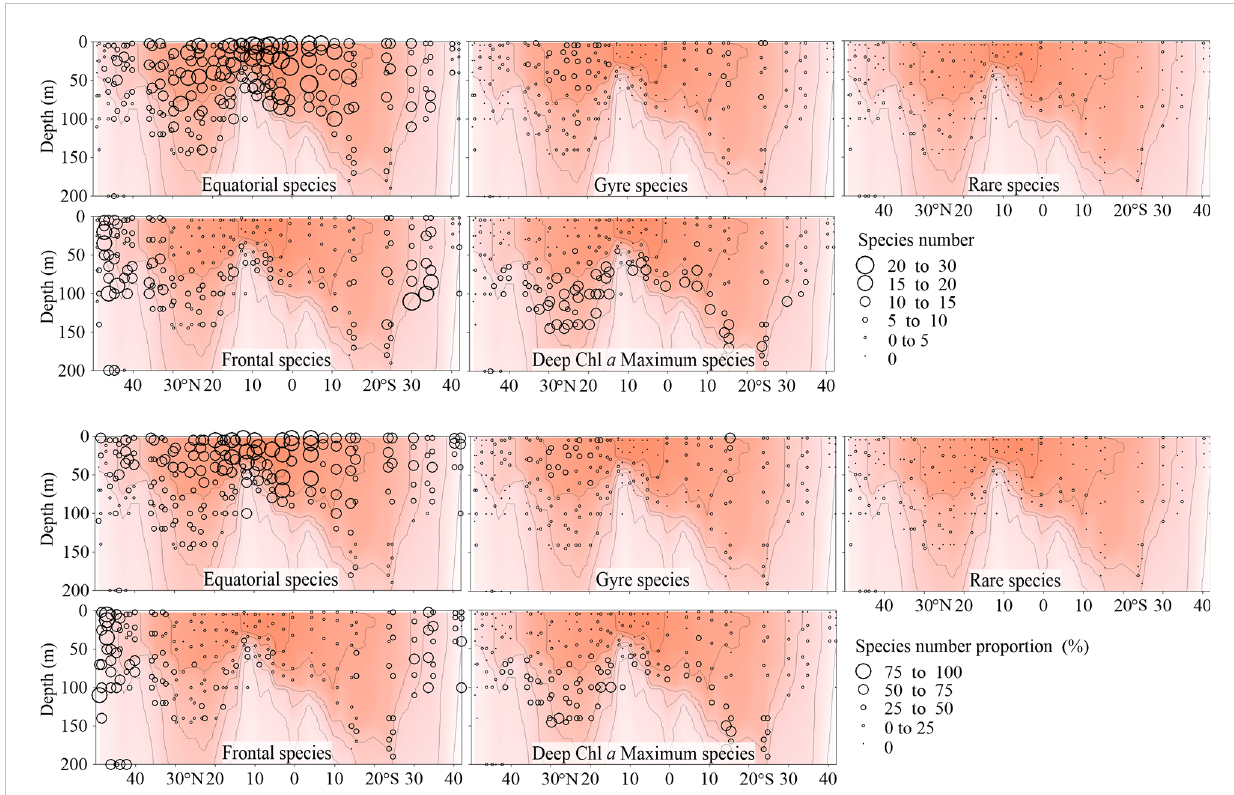
FIGURE 6 Vertical distribution of Tintinnina species number (upper panel) and proportion (%, lower panel) in each biogeographic region along the AMT transect. The red color and isothermal lines are temperature (°C) as in Figure 2. Black dots denote the locations of sample